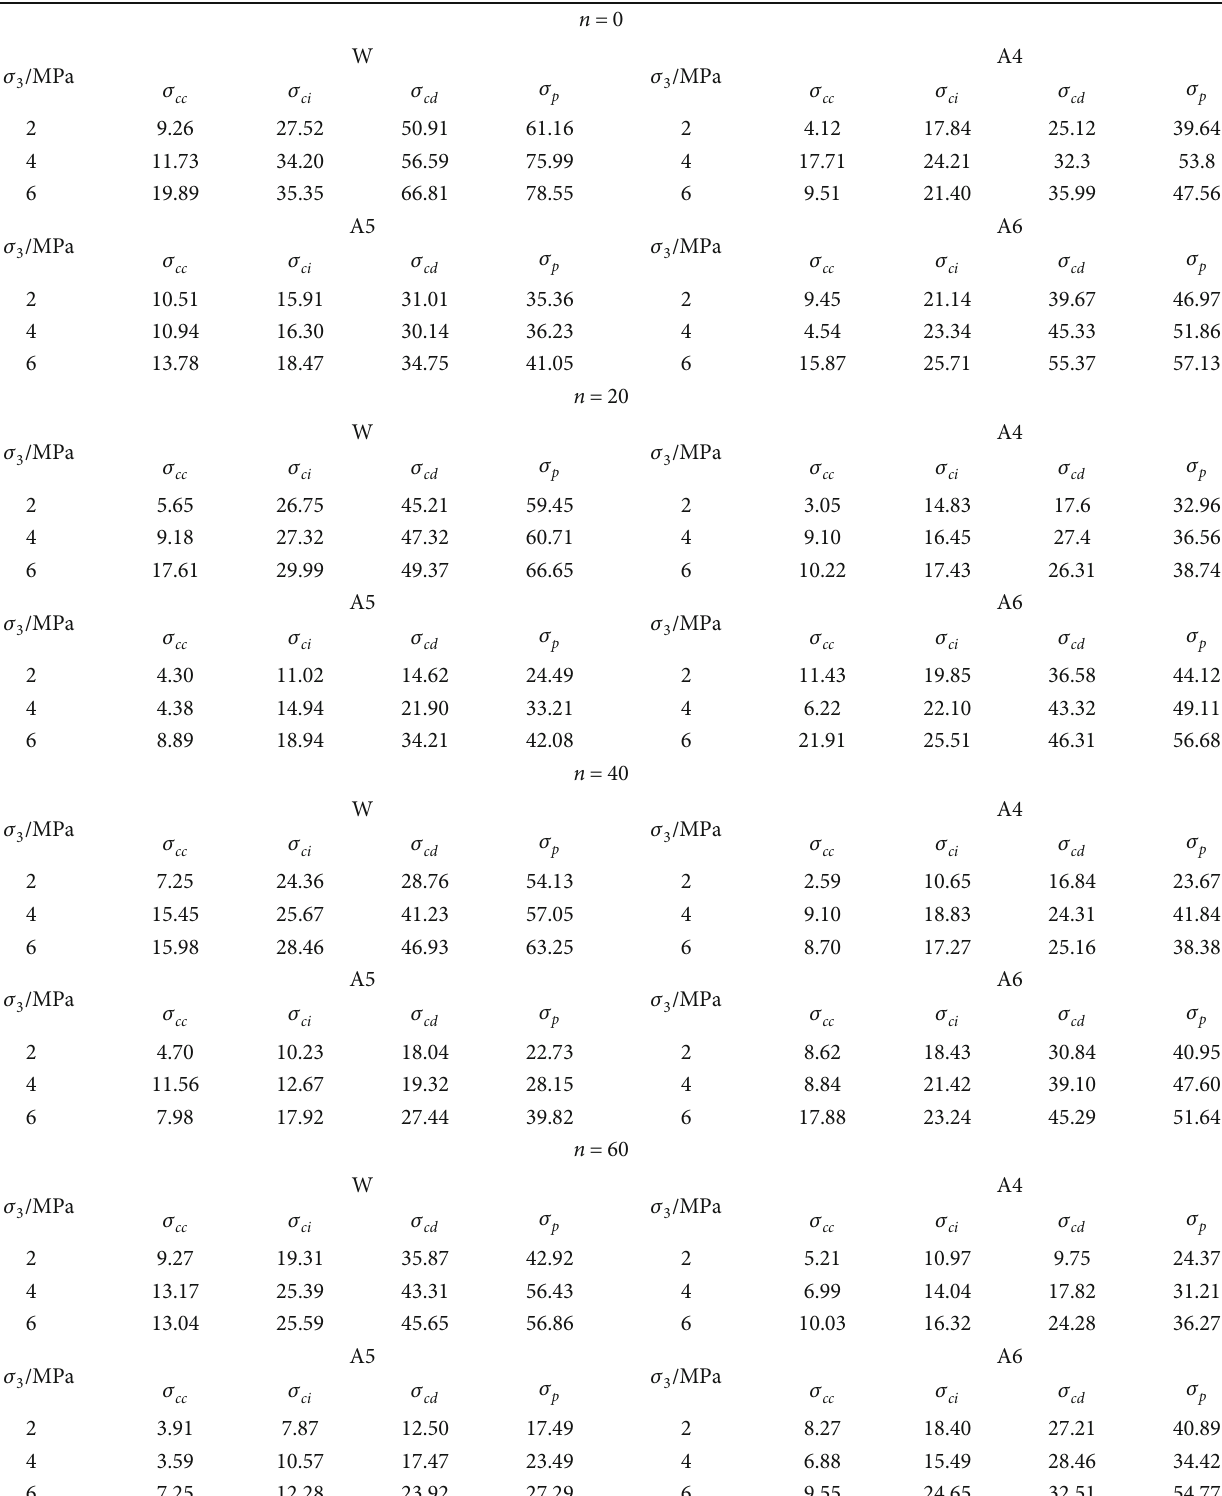
Table 2: The characteristic stresses of intact rock and di ff erent fractured rocks under di ff erent con fi ning stresses and freezing and thawing